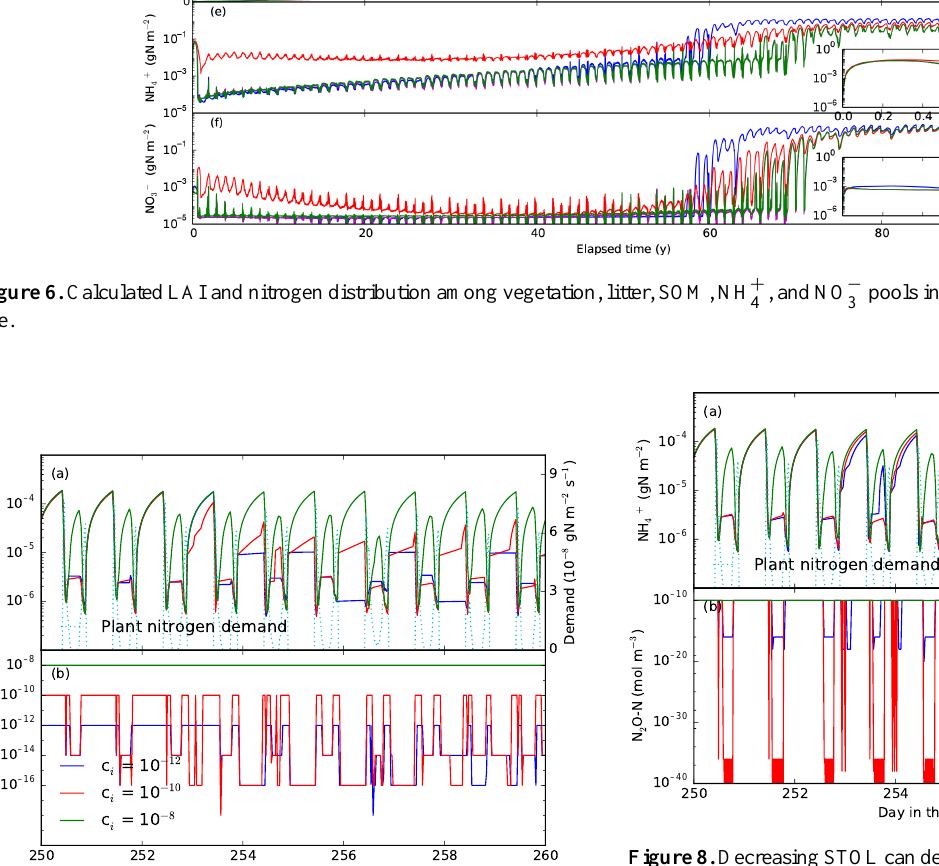
Figure 8. Decreasing STOL can decrease and eliminate the numeri- cal inhibition in the case of c i = 10 − 10 molm − 3 in Fig. 7. N 2 O − N concentration in the y axis in (b) is the minimum of the 10 soil